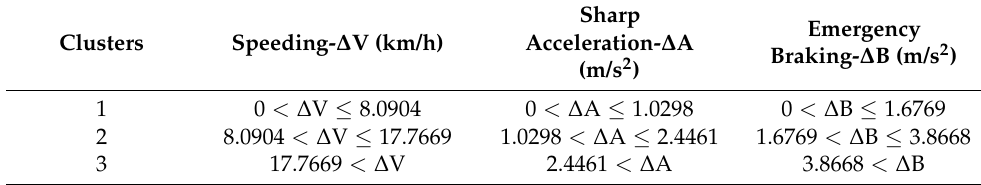
Table 1. Clustering results of risky driving